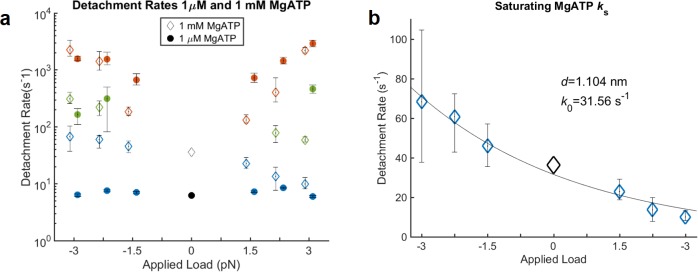
Kinetics of actomyosin detachment in the presence of 1 mM MgATP.(a) Fitted detachment rate constants, kf (red), kint (green), and ks (blue) in the presence of 1 μM MgATP (closed circles, same data as in text Figure 2f) and 1 mM MgATP (open diamonds). The zero-load rates (black) are from non-feedback experiments. kf and kint do not vary systematically between low and high ATP concentration, while ks is faster and more force dependent at 1 mM than at 1 μM MgATP. (b) ks at 1 mM MgATP with a fitted Bell equation, yielding a distance parameter of 1.1 nm. The estimated unloaded rate (k0 = 31.5 s−1) is slightly less than some previous measurements (50–70 s−1), which may be at least partially due to mixing of the slow and intermediate phases in the fitted parameters. Such mixing may also be responsible for the differences in kint for 1 μM vs. 1 mM MgATP under resisting loads.